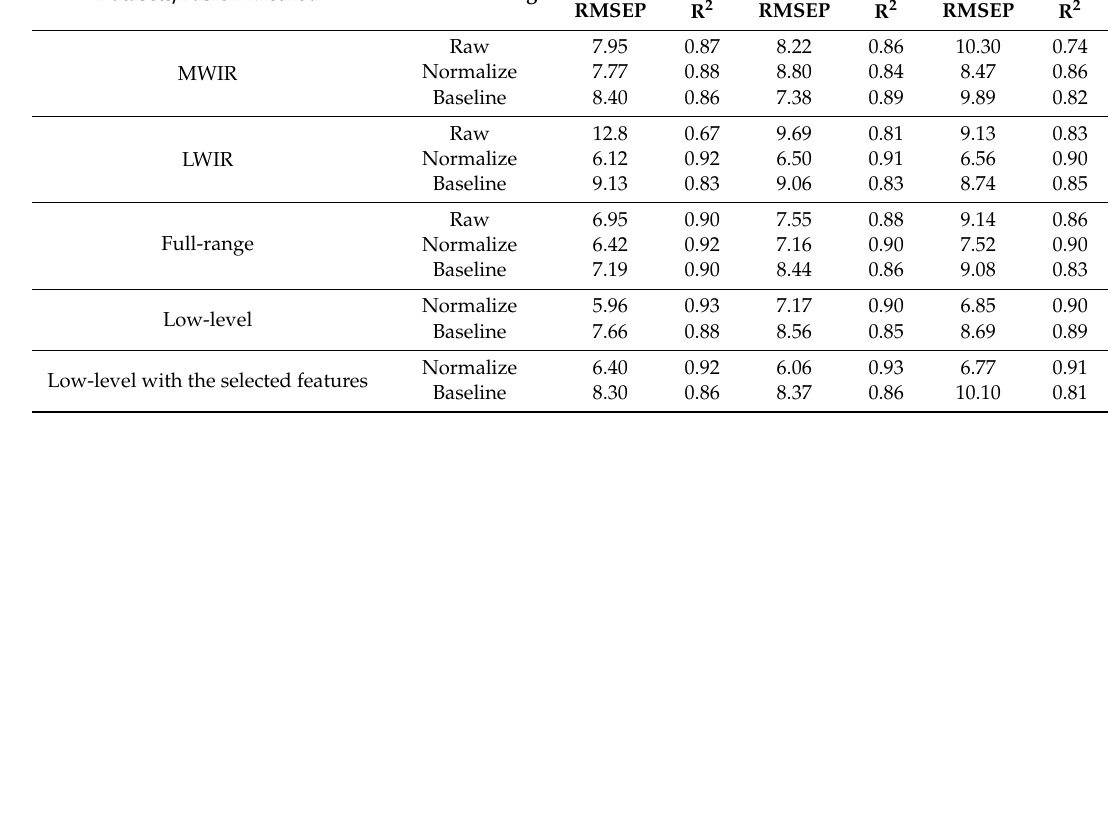
Table 2. Statistical summary of the PLSR, PCR, and SVR models for the prediction of SiO 2 . The concentrations of SiO 2 in the analysed samples were in the range of 1.66 − 84.1 wt%. Datasets / Fusion